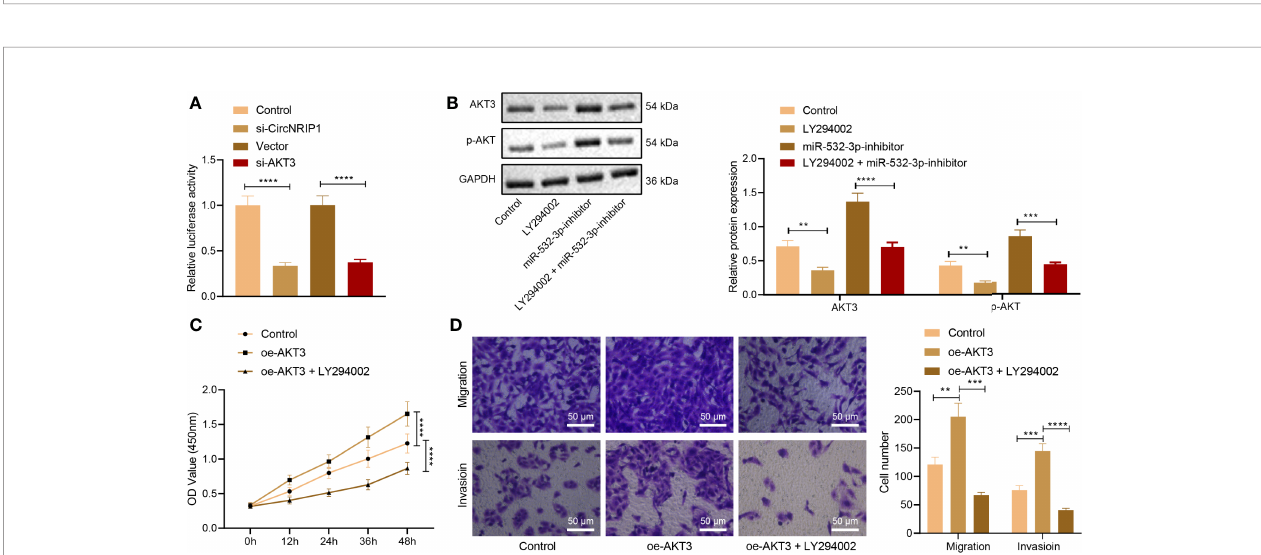
FIGURE 6 | circNRIP1 induces activation of the PI3K/AKT signaling pathway via blockade of miR-532-3p-mediated AKT3 inhibition, thus facilitating the malignant phenotype of osteosarcoma cells. (A) The luciferase activity of the PI3K/AKT signaling pathway-related genes determined by dual-luciferase reporter assay upon knockdown of circNRIP1 or AKT3. (B) Western blot analysis of AKT3 and p-AKT3 protein levels in MG63 cells treated with oe-AKT3 or combined with LY294002. (C) Proliferation of MG63 cells treated with oe-AKT3 or combined with LY294002 measured by CCK-8. (D) Migration and invasion of MG63 cells treated with oe-AKT3 or combined with LY294002 measured by Transwell assay. ** p < 0.01. *** p < 0.001. **** p < 0.0001. Data are shown as mean ± standard deviation of three technical replicates. Data among multiple groups were compared with one-way ANOVA, followed by Tukey ’ s post hoc tests. The repeated measures ANOVA with Bonferroni post hoc test was applied for the comparison of data at different time